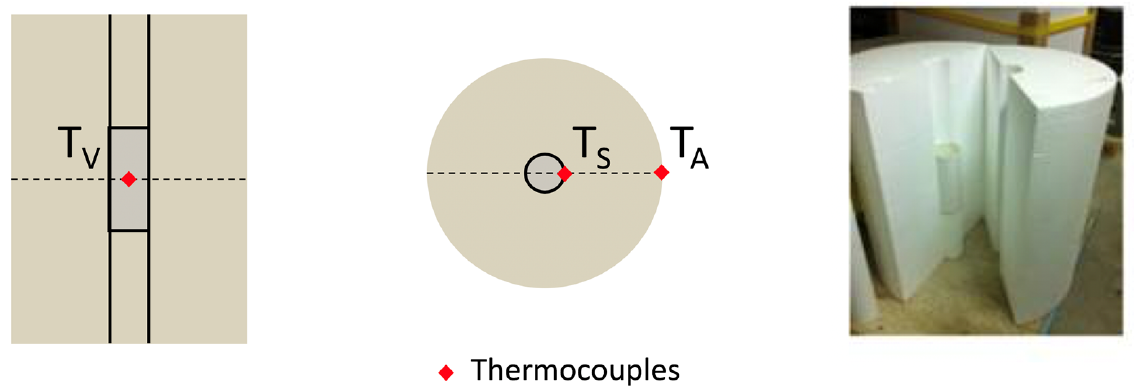
Figure 1. SAC apparatus and the position of the thermocouple.